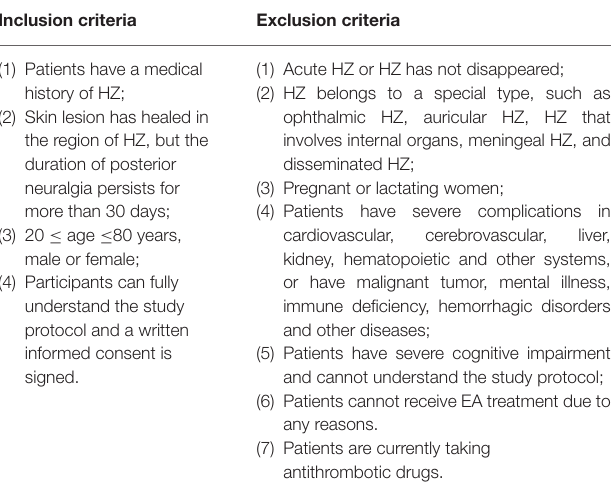
TABLE 2 | The inclusion criteria and exclusion criteria of PHN patients. Inclusion criteria Exclusion